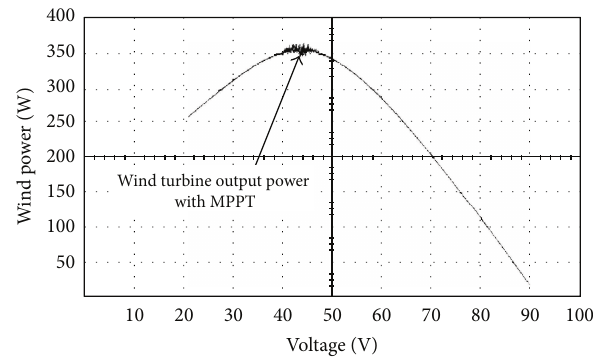
Figure 14: Measured result: drawn power from wind turbine with MPPT.